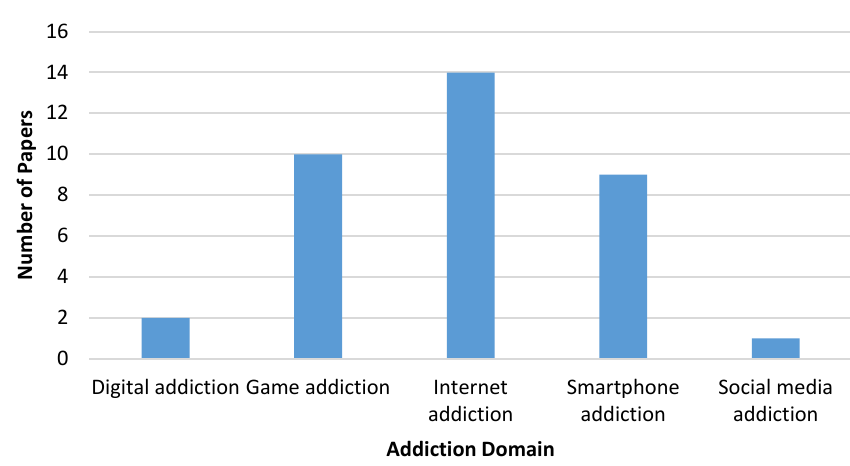
Figure 7. The distribution of studies by addiction domain.